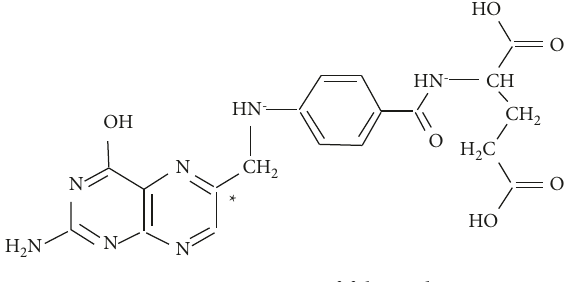
Figure 1: Structure of folic